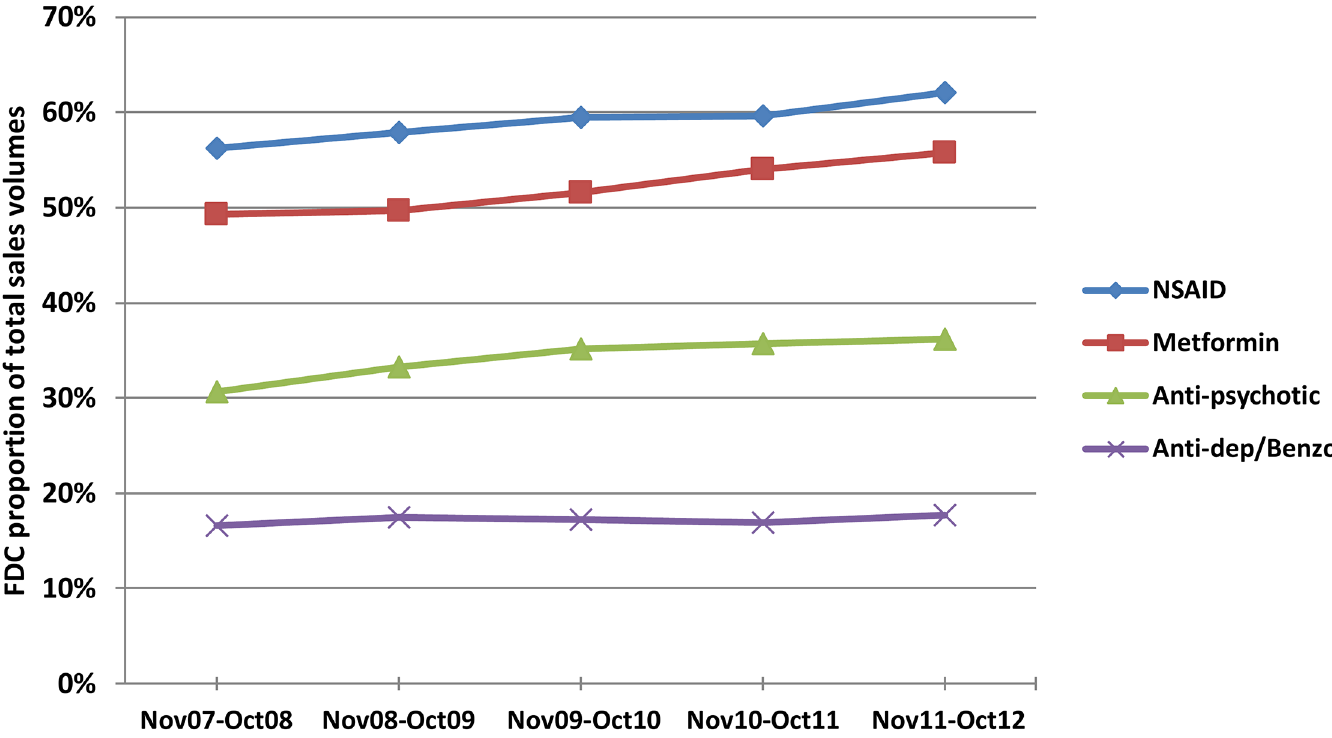
Fig 2. FDCs as proportions of total annual oral drug sales volumes in each therapeutic area, November 2007 – October 2012. Metformin FDCs are expressed as a percent of total oral diabetes drugs. Numerator and denominator data are included in S3